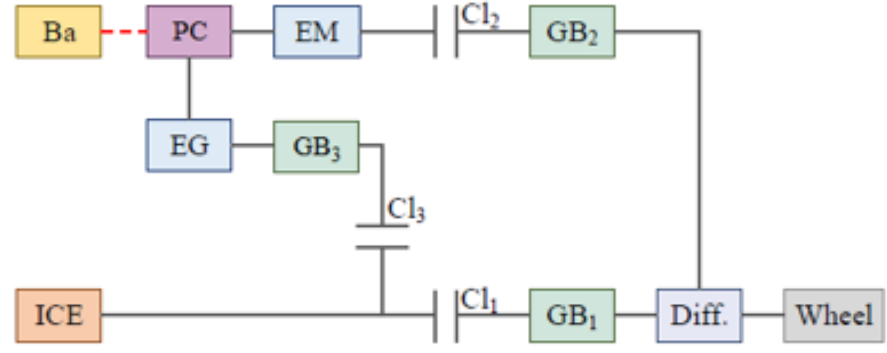
Figure 4. Hybrid powertrain